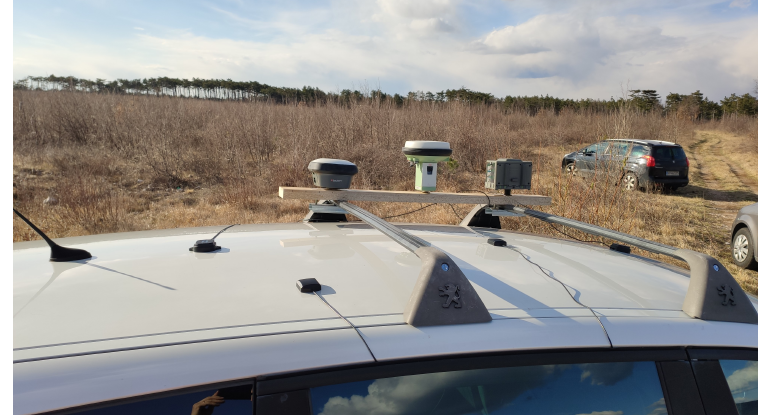
Figure 1. GNSS receivers set up on the roof of the vehicle (own study).